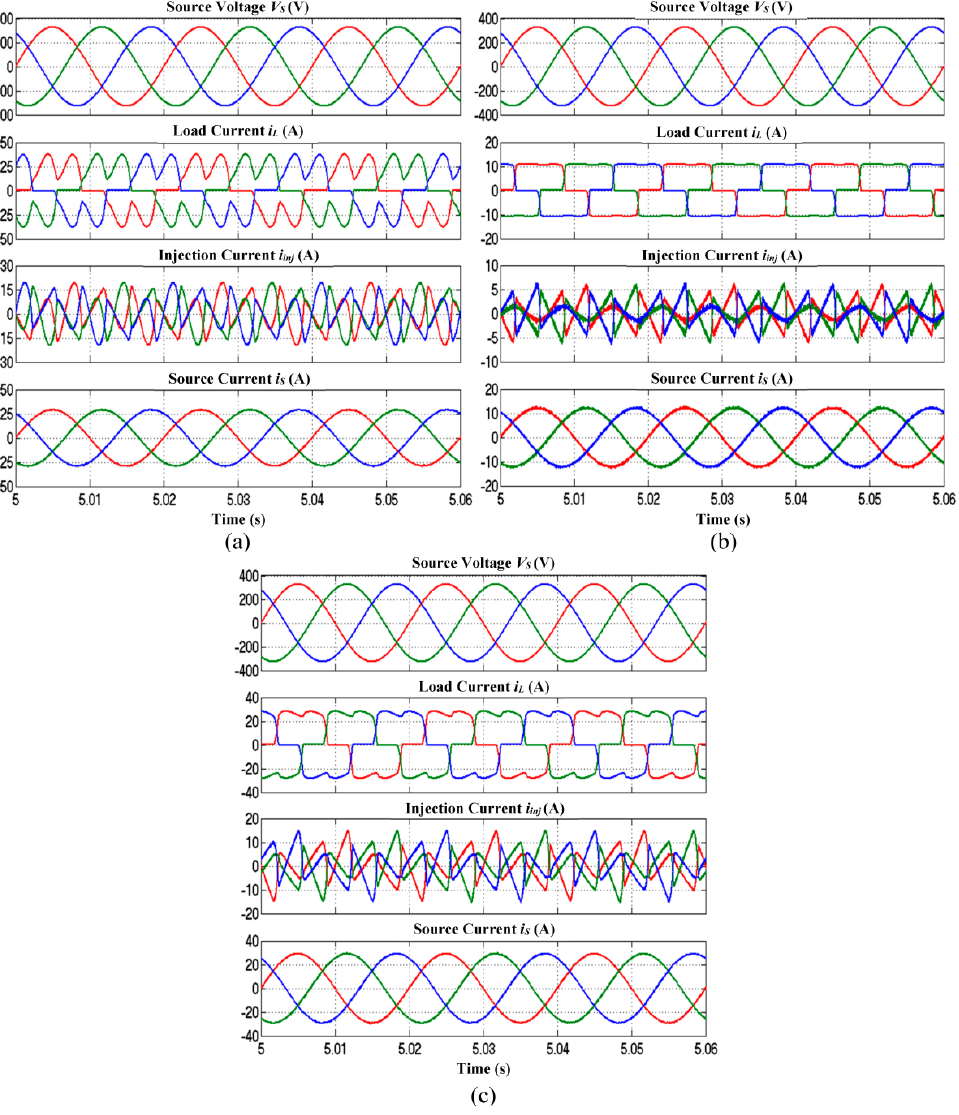
Figure 6. Simulation results of SAPF utilizing the proposed algorithm with IED control which include three-phase source voltage 𝑣 𝑆 , load current 𝑖 𝐿 , injection current 𝑖 𝑖𝑛𝑗 and source current 𝑖 𝑆 for ( a ) capacitive; ( b ) inductive and ( c ) resistive loads.